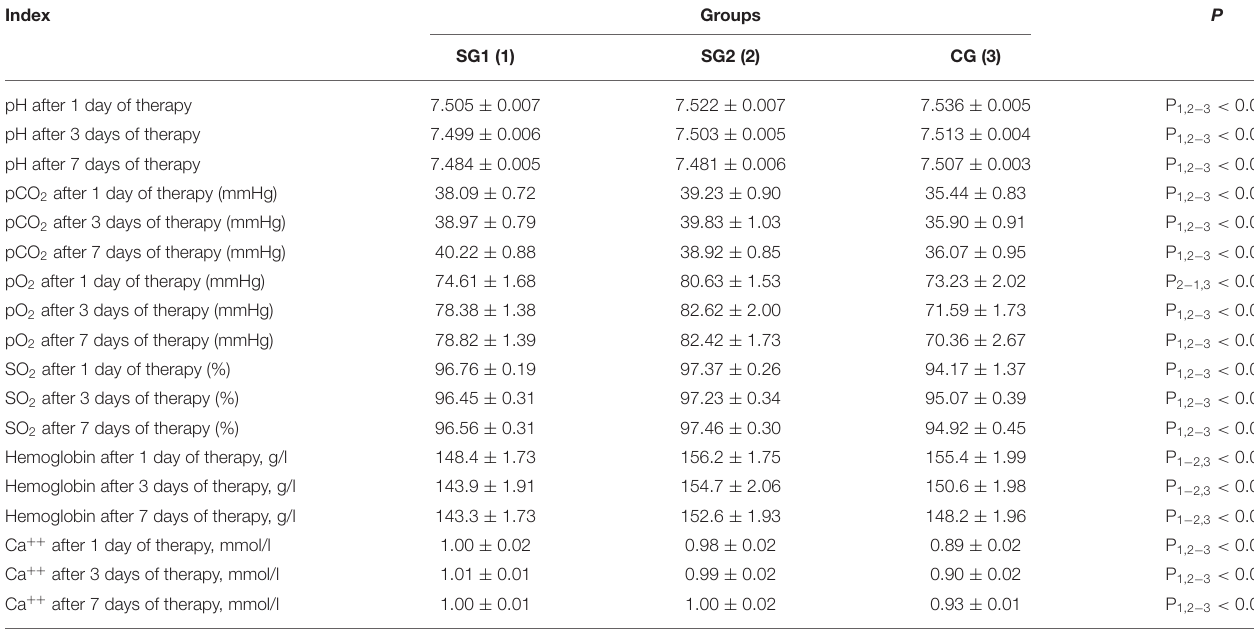
TABLE 1 | The dynamic changes of blood acid-base